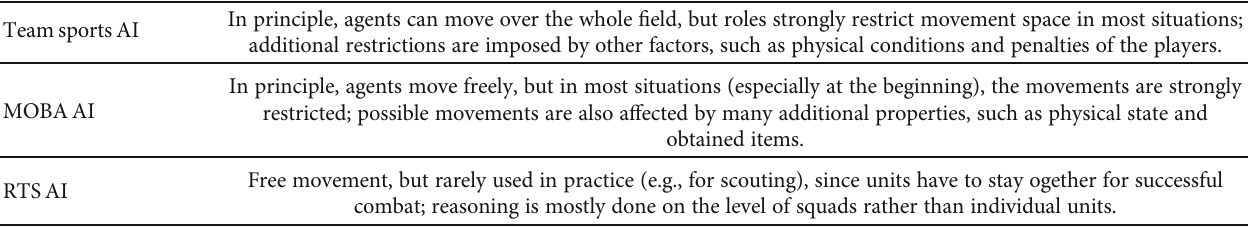
Table 6: Rhythm/independent episodes property. Is it possible to change the strategy easily (replan requirement)? Team sportsAI MOBA